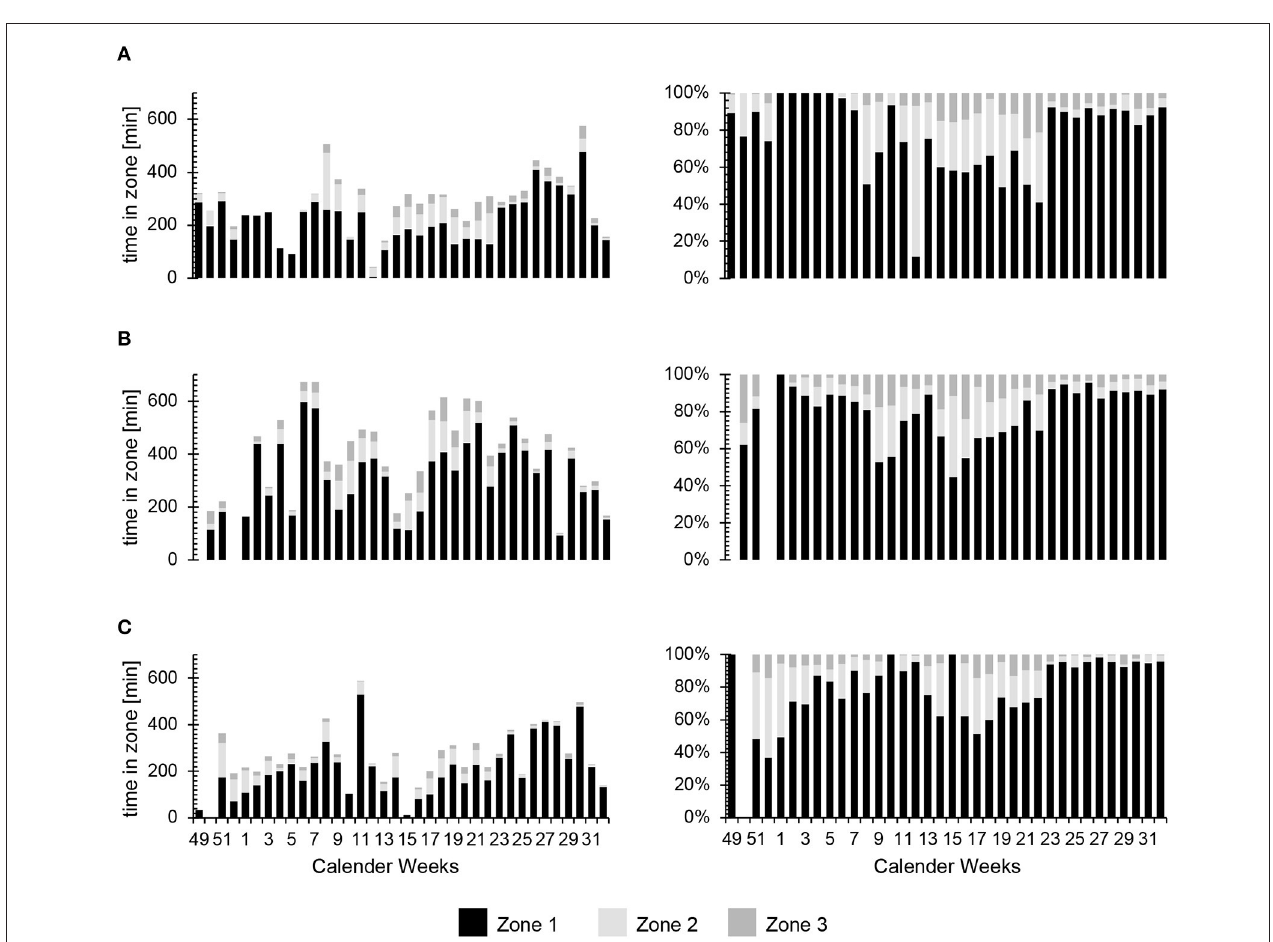
FIGURE 5 | Representative values for the absolute (min) and relative (%) amounts of time spent in the different training zones during each week of the period of observation. (A) Participant 7, (B) Participant 4 and (C) Participant